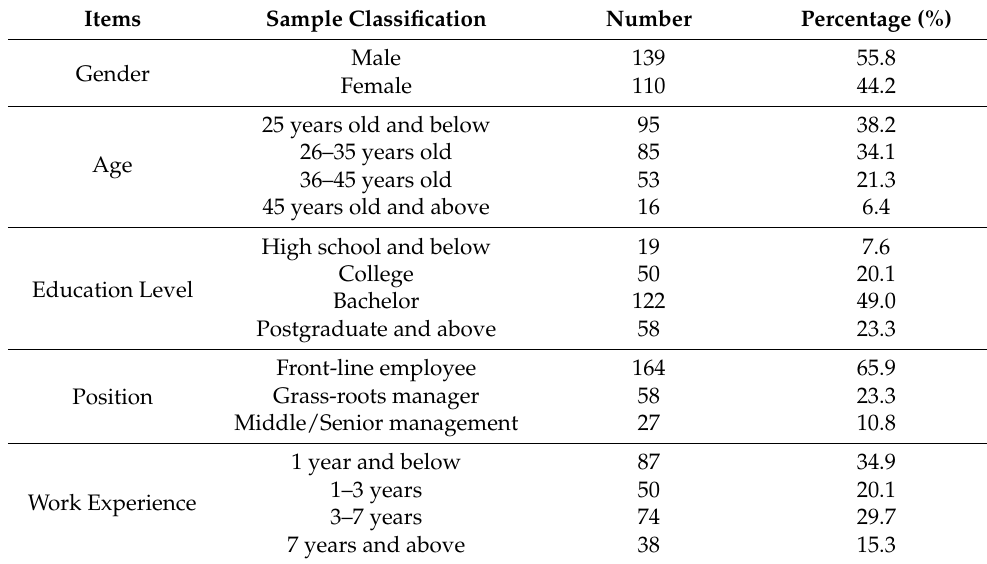
Table 1. Sample basic